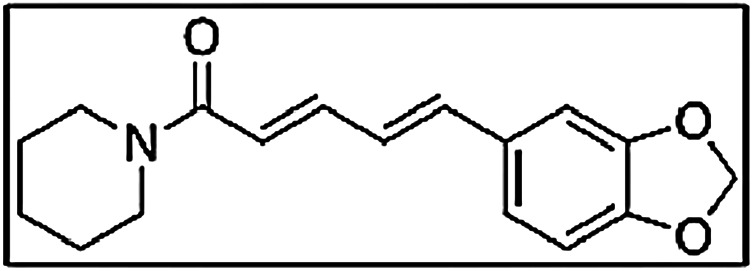
Structure of piperine.